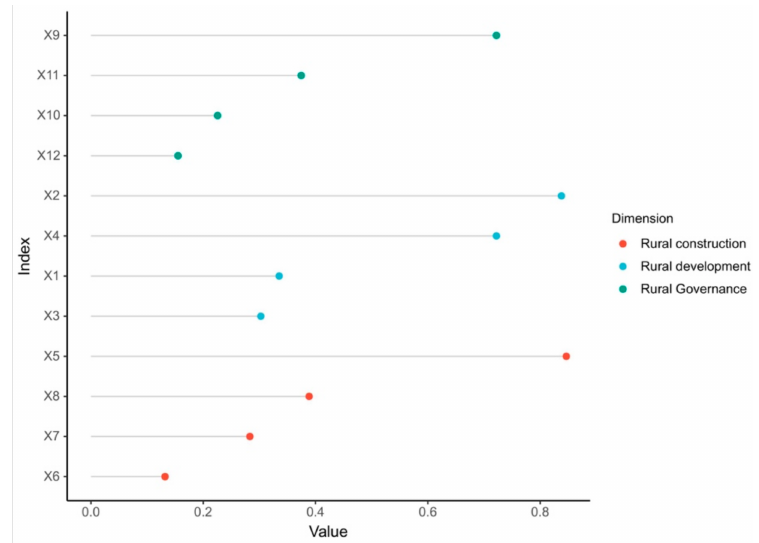
Figure 8. Results of impact factor detection of rural revitalization level in the Jinggangshan rural revitalization demonstration